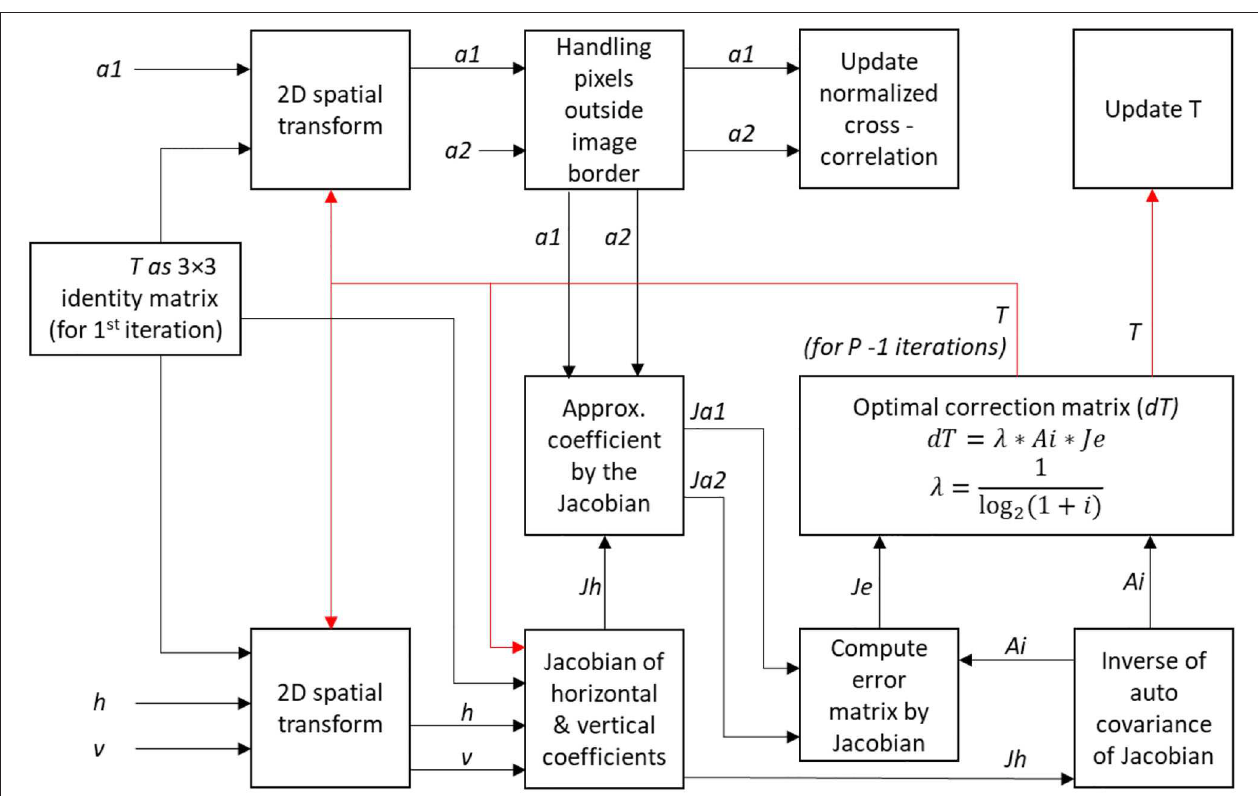
FIGURE 8 | Flowchart of Jacobian optimization of transformation matrix